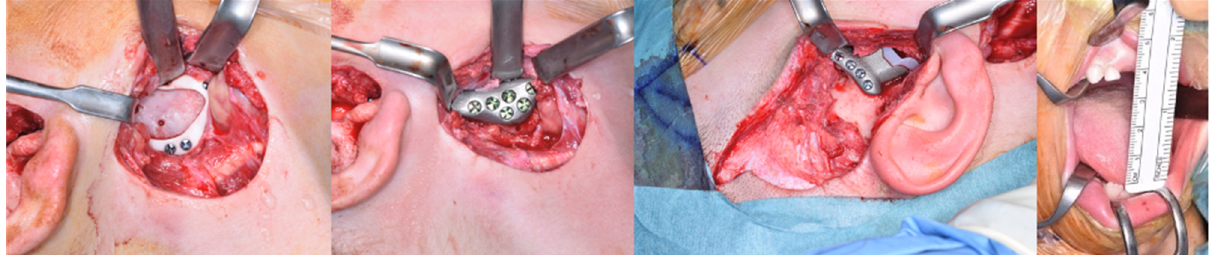
Figure 8. The custom-made prosthesis was then positioned and the MMO was checked.